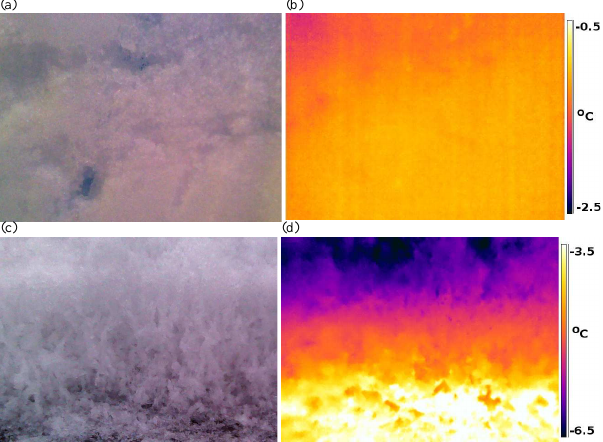
Fig. 2. Left : Visual spectrum photographs of two areas with complex surface and grain qualities. Right : Thermographs depicting the same areas. Images (a) and (b) are of a visually complex crust with relatively uniform temperatures. The images capture an area ∼ 30 cm in width. Images (c) and (d) are of a visually complex layer of depth hoar with complex temperatures. The images capture an area ∼ 10cm in width.